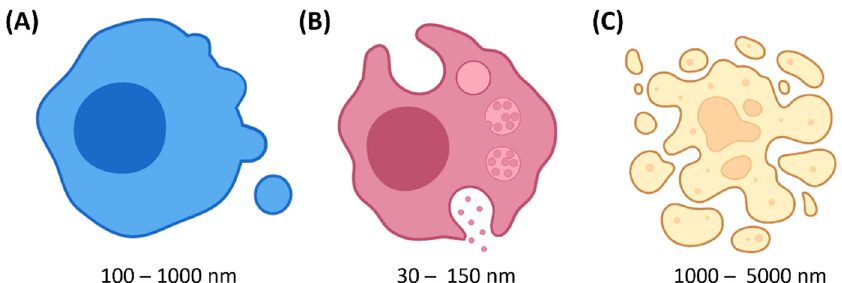
Figure 2. Schematic representation of the production mode of the different types of EVs. ( A ) Microvesicles are produced by direct budding at the plasma membrane. ( B ) Exosomes are released by exocytosis of a multivesicular body itself formed by the inward budding of a late endosome. ( C ) Apoptotic bodies are fragments of dying cells. Schemes are not to scale.